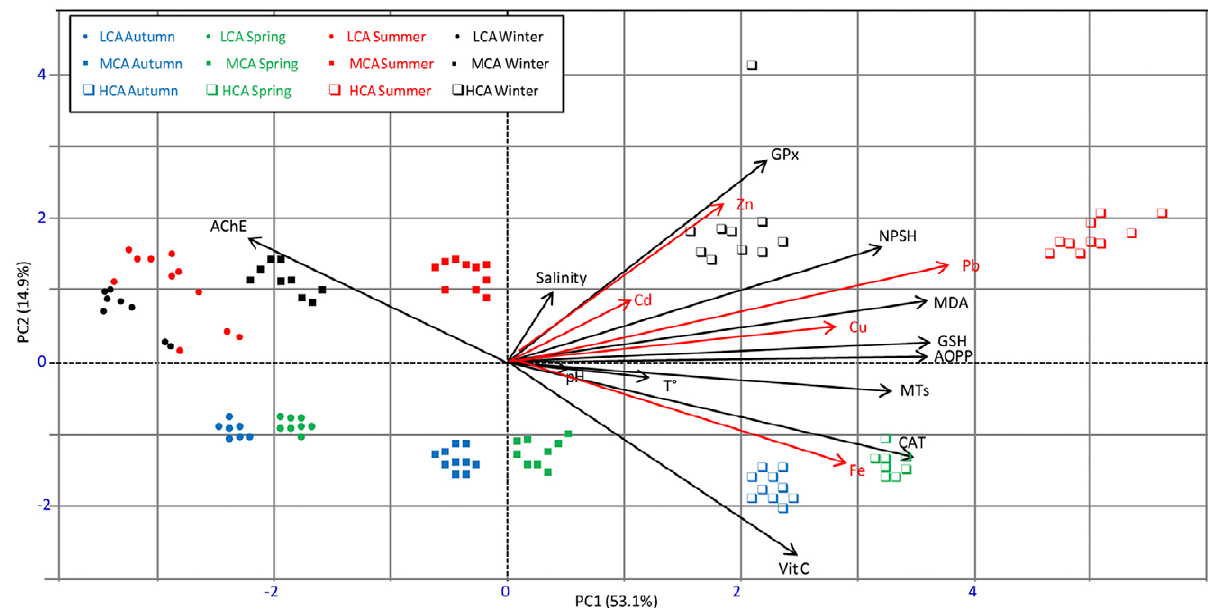
Fig. 4. – Principal analysis component results represented by two factors and produced by abiotic factor, biochemical and chemical variables measured in the digestive gland of R. decussatus sampled from three costal Tunisian